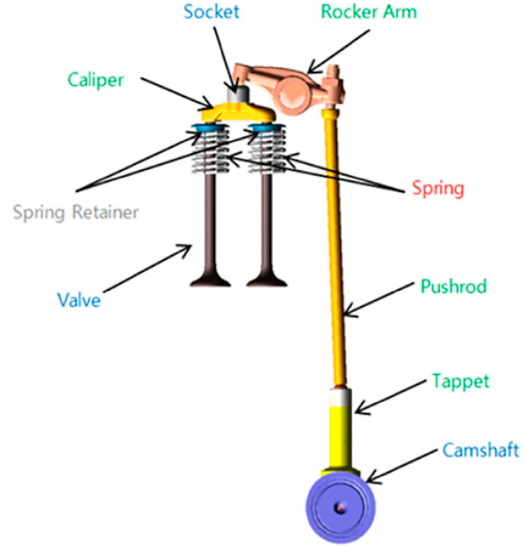
Figure 1. Schematic diagram of the diesel engine valve train.